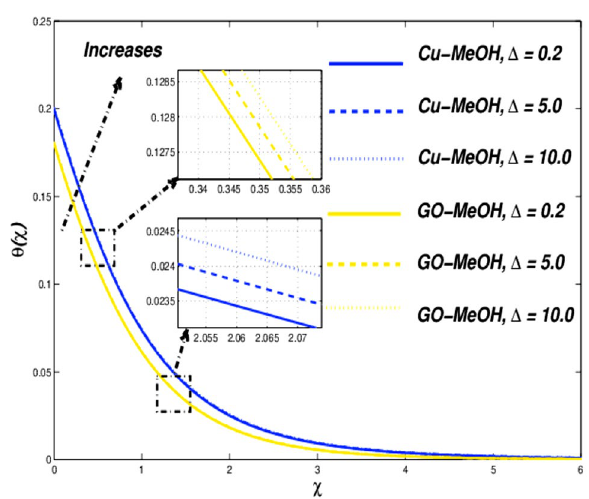
Figure 5. Temperature variation versus (cid:31) .